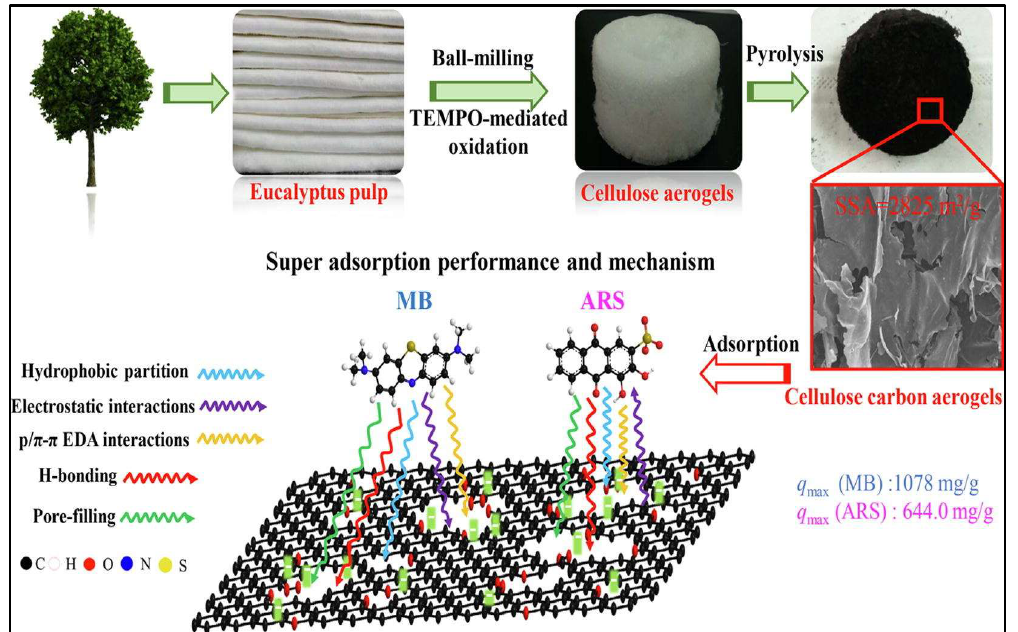
Figure 5. Illustration of cellulose carbon aerogel for enhanced organic dyes adsorption from aque- ous solution. Adapted from Huang et al. [94]